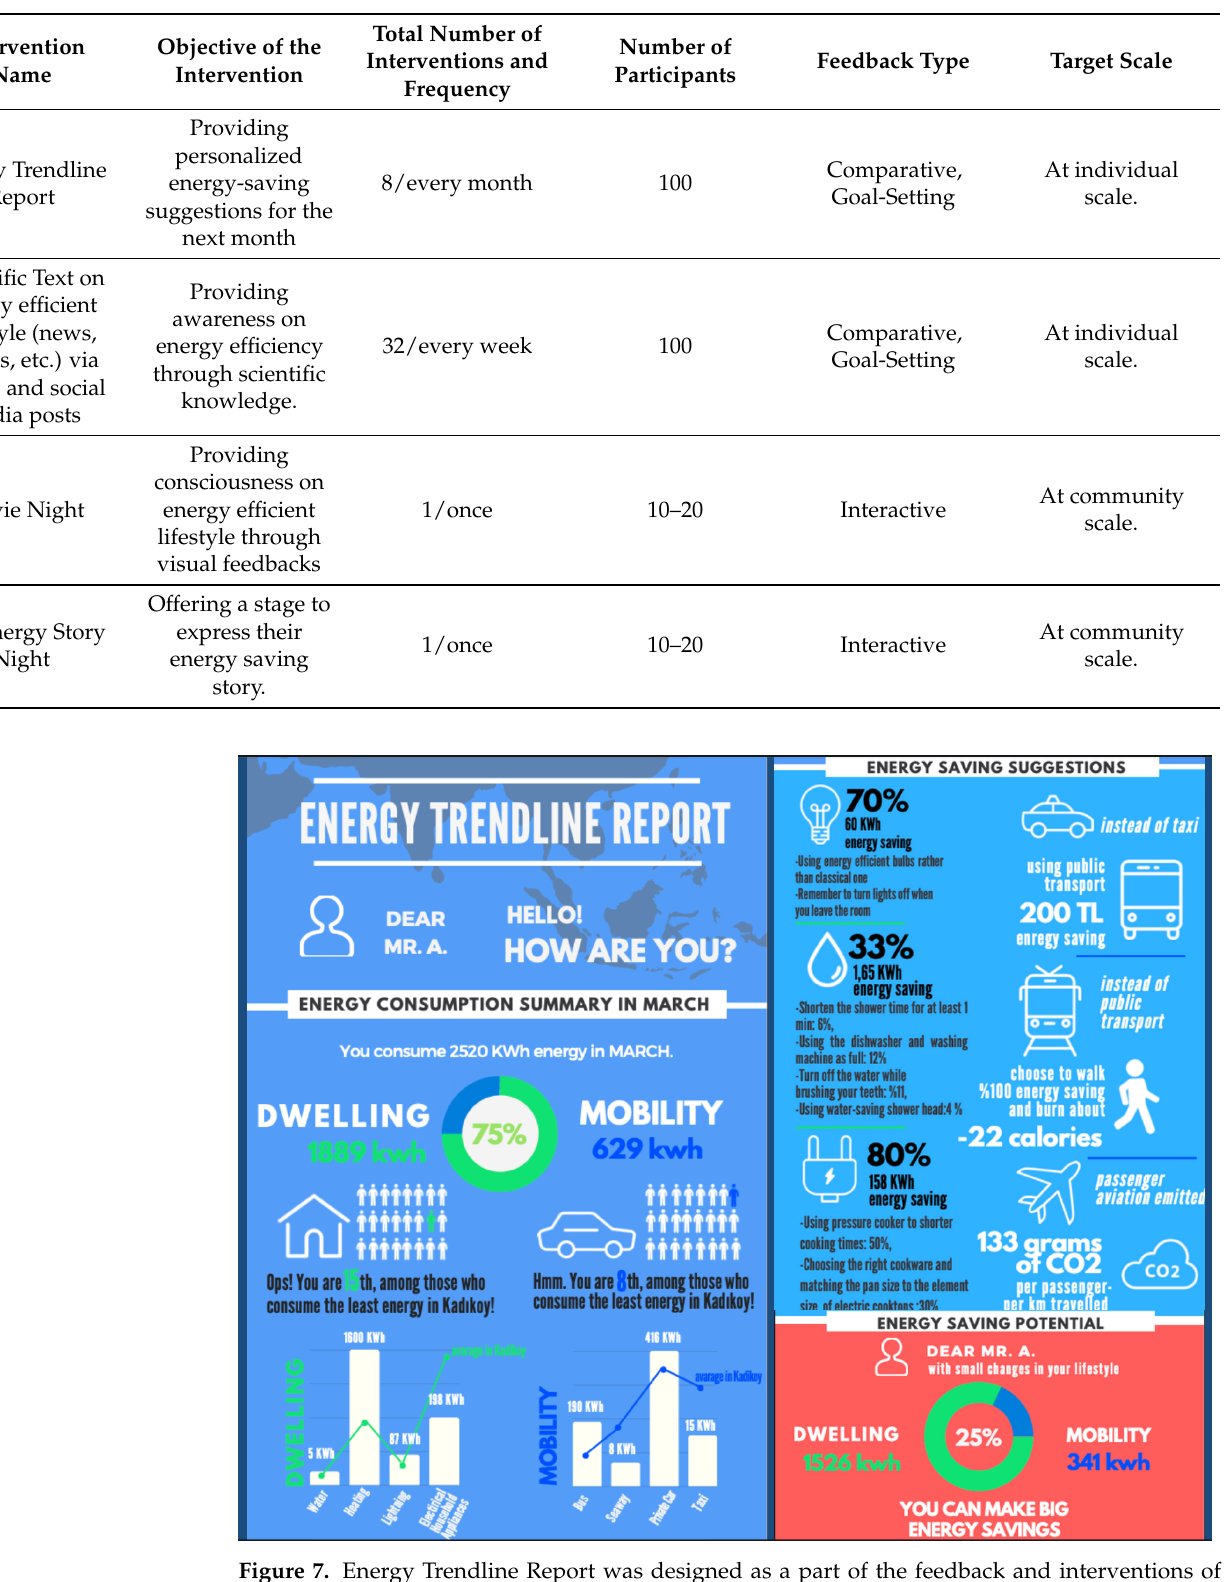
Table 8. Feedback and Intervention Plan.